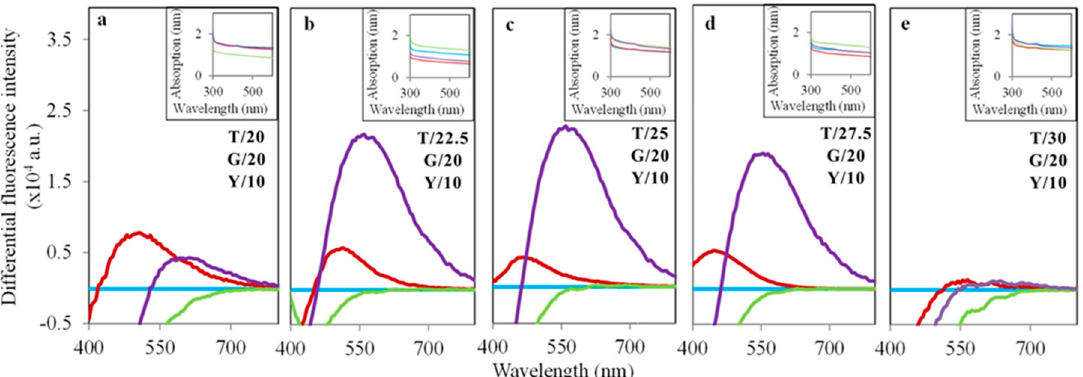
Figure 1. Di ff erential fluorescence spectra (excitation at 350 nm) of yeasts cultivated in the Tryptone Glucose Yeast extract media (TGY) with the precursors for QD biosynthesis (CdCl 2 and Na 2 SeO 3 ). Di ff erent concentrations of tryptone (20–30 g / L) were added to the medium to optimize QD biosynthesis ( a – e ). The concentrations (g / L) of tryptone (T), glucose (G), and yeast extract (Y) are mentioned in each figure. Sky blue spectra denote the control (C) variant without the addition of CdCl 2 and Na 2 SeO 3 . Red, green, and purple spectra represent the variant with the addition of only CdCl 2 (Cd), Na 2 SeO 3 (Se), and both (CdSe), respectively. Absorbance spectra are shown in the insets.